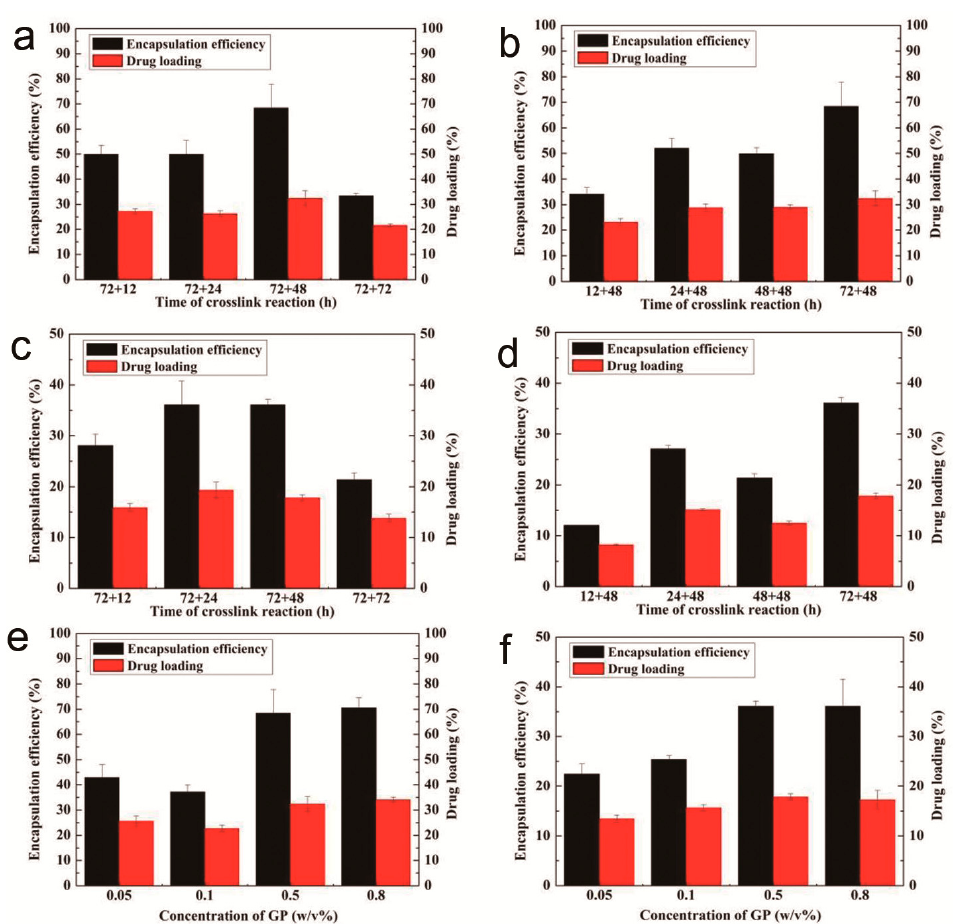
Figure 2. Drug-loading and encapsulation efficiency of ADBMs-P preparation with different crosslinking reaction times: ( a , b ) Ara-C; and ( c , d ) DNR; and different GP concentration: ( e ) Ara-C; and ( f ) DNR.